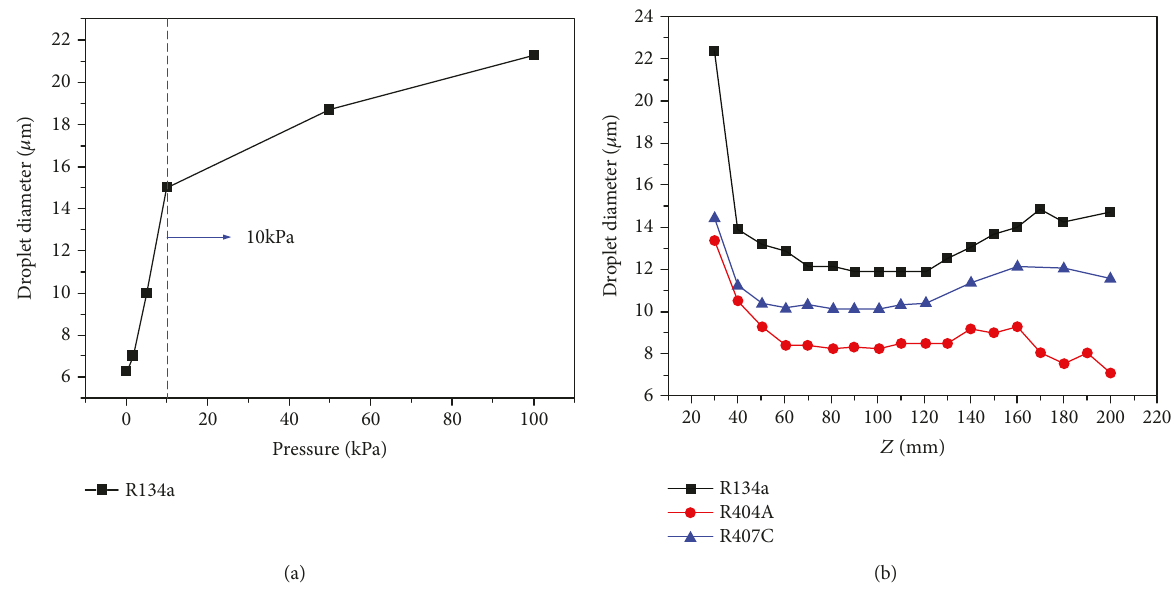
Figure 7: (a) Droplet diameter ( D 32 ) of spray back pressure at the spray distance of 30mm [45]. (b) Droplet diameter ( D 32 ) along the spray central line [4].